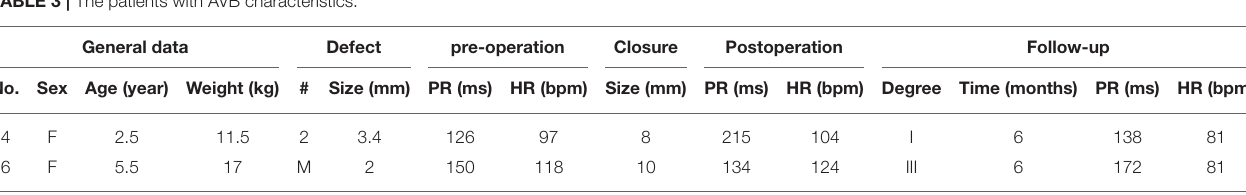
TABLE 3 | The patients with AVB